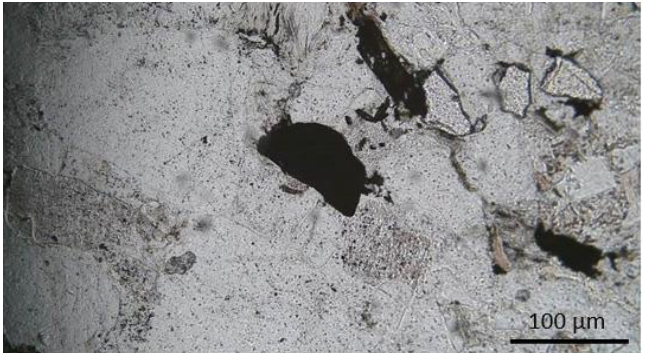
Figure 15. Crumbs of carbonaceous matter: one polar—100× magnification.